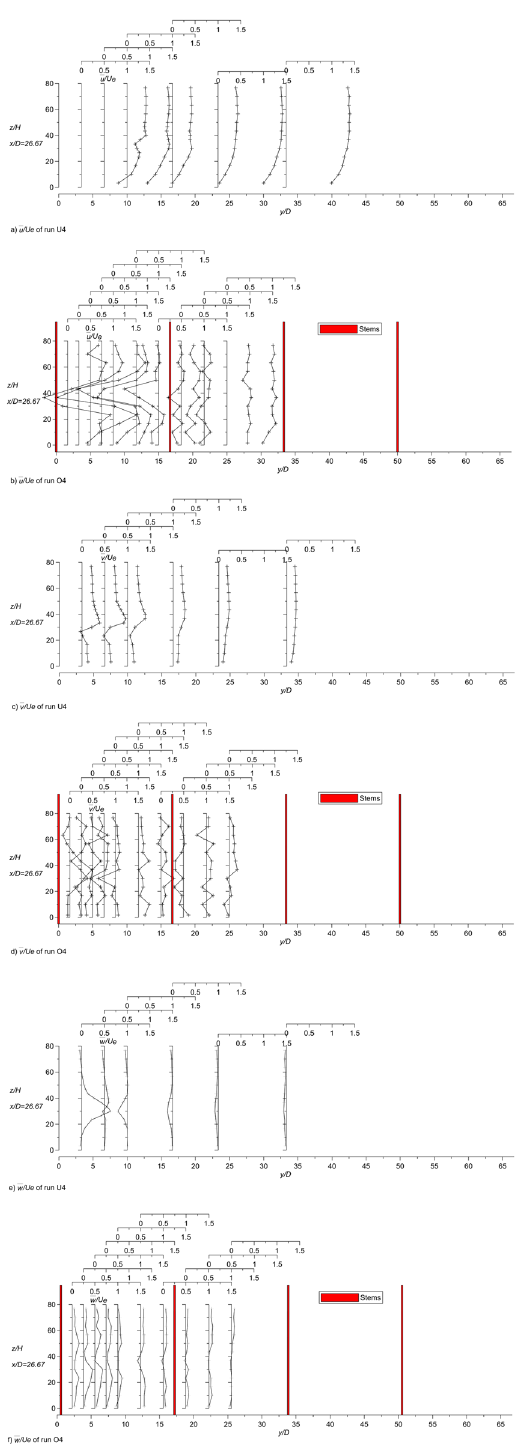
Figure 4. Transversal profiles of the dimensionless time-averaged longitudinal u , transversal v and vertical w velocity components of runs U4 and